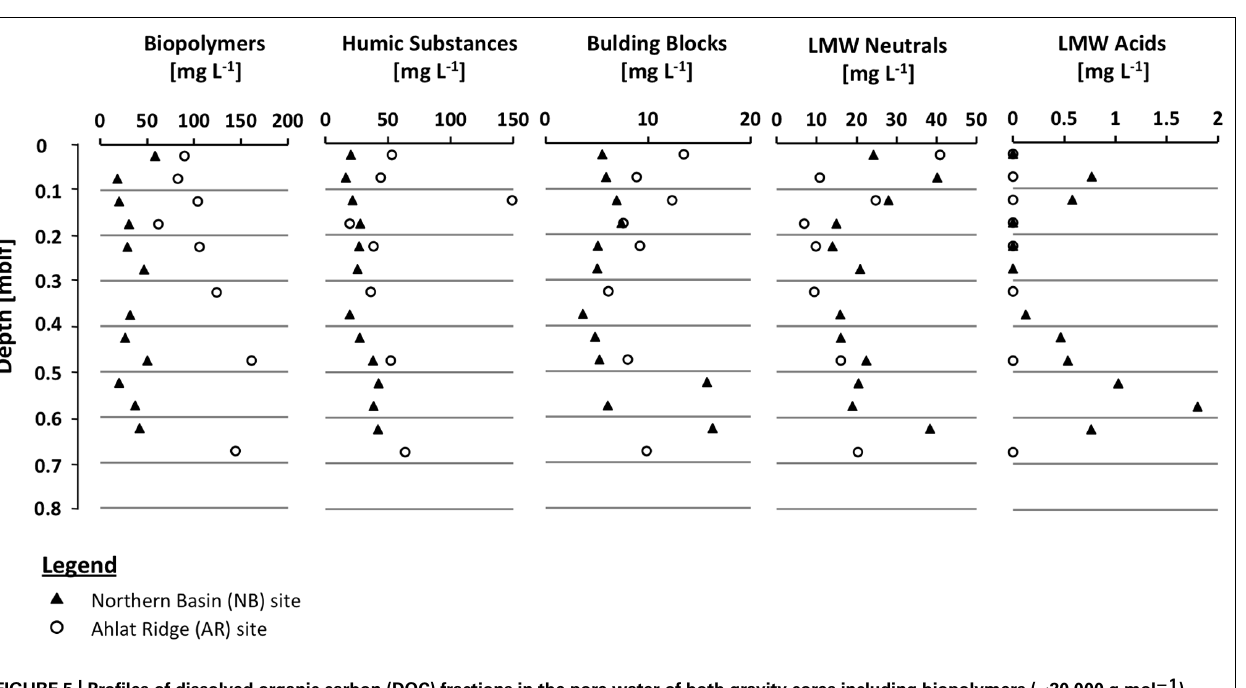
FIGURE 5 | Profiles of dissolved organic carbon (DOC) fractions in the pore water of both gravity cores including biopolymers ( < 20,000 g mol − 1 ), humic substances ( ∼ 1,000 g mol − 1 ), building blocks (fragments of humic substances, 300–500 g mol − 1 ), low molecular weight (LMW) neutrals ( < 350 g mol − 1 ) and low molecular weight (LMW) acids ( < 350 g mol − 1